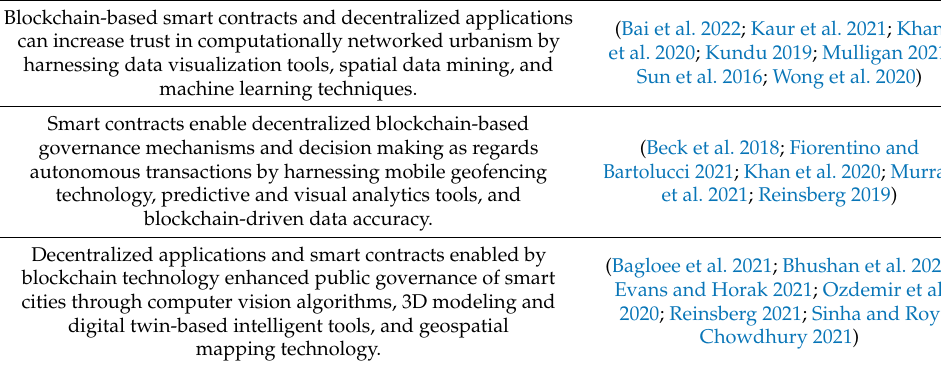
Table 5. Synopsis of evidence as regards focus topics and descriptive